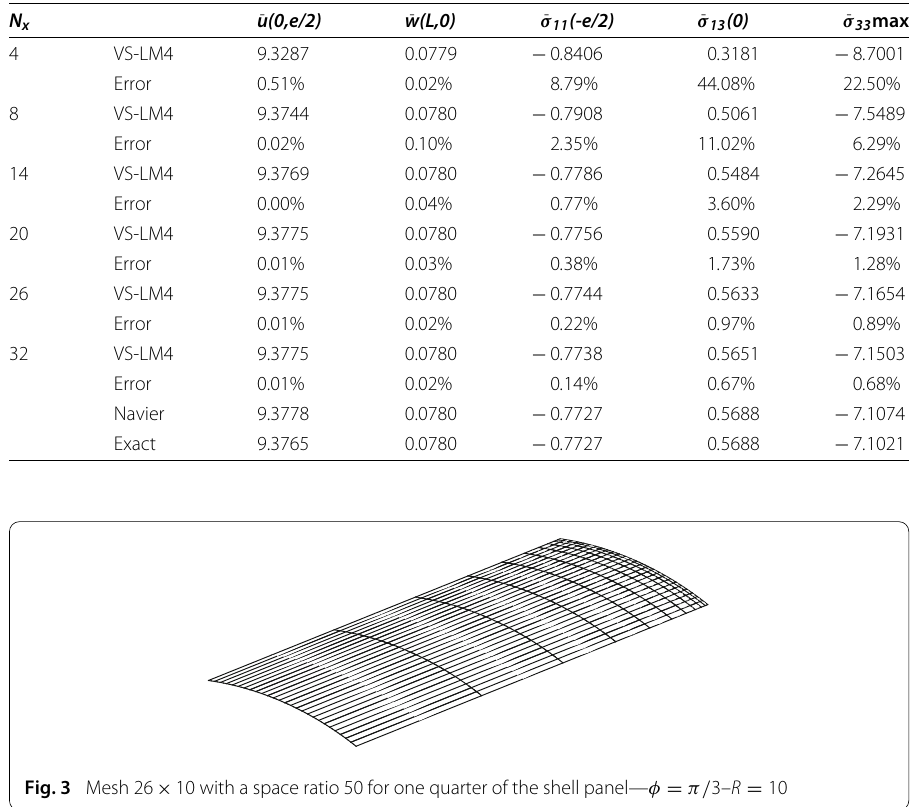
Table 1 Convergence study—one layer [0 ◦ ] —S = 40— φ = π/ 3 — N z = NC —mesh N x × 10 with space ratio (50)